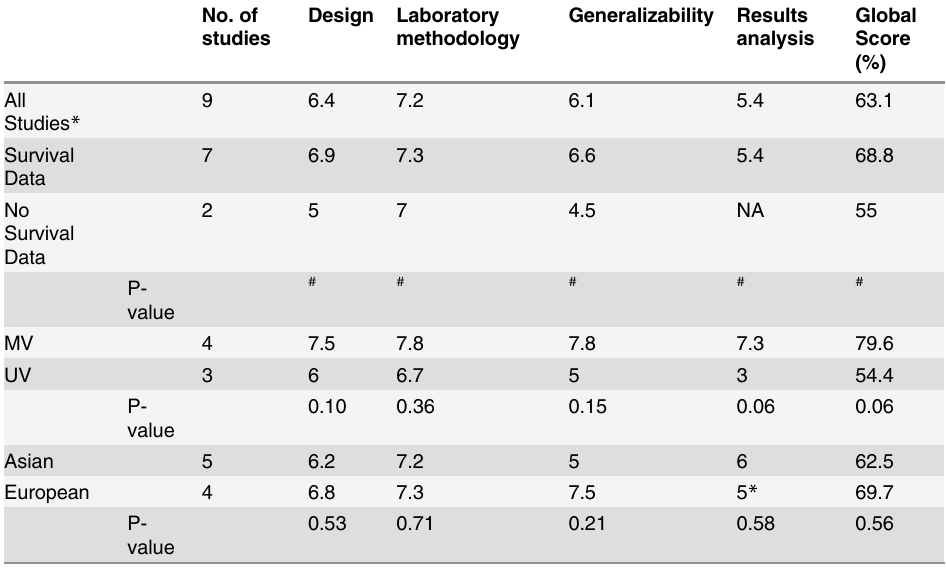
Table 2. Study quality assessment according to the ELCWP